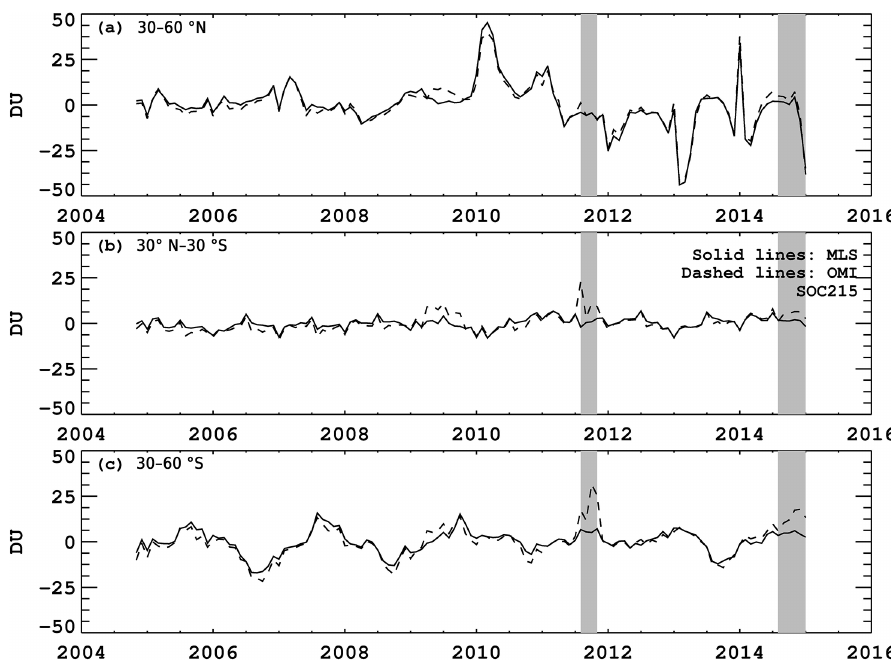
Figure 3. Deseasonalized time series of monthly mean MLS (solid lines) and OMI (dashed lines) stratospheric ozone columns down to 215hPa (SOC215s) in (a) 30–60 ◦ N, (b) 30 ◦ N–30 ◦ S, and (c) 60–30 ◦ S. The periods that have been omitted in our analysis are marked as gray